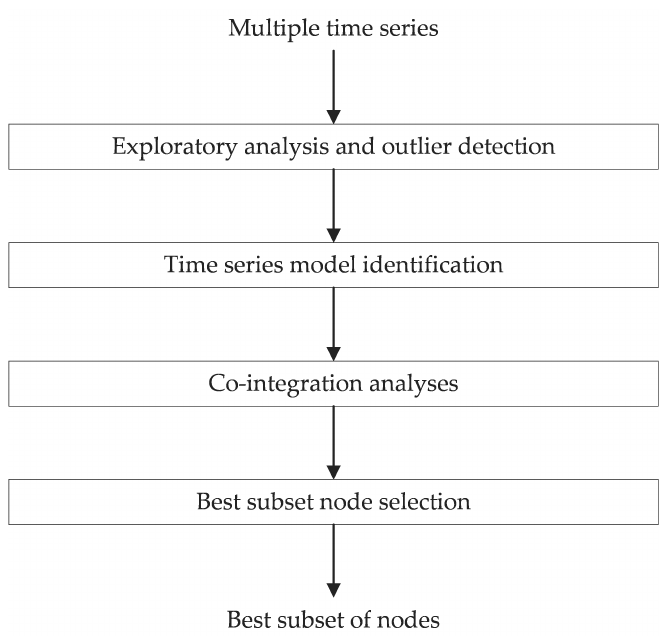
Figure 2. Multivariate time series analysis framework.